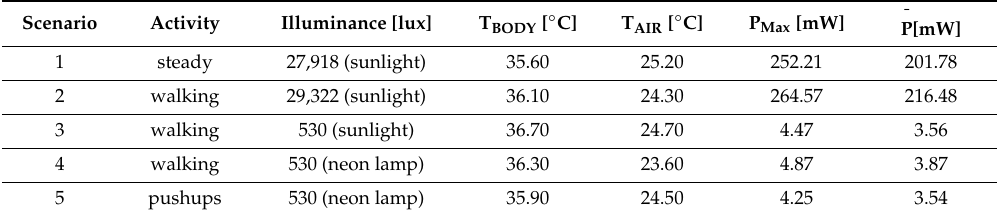
Table 4. Characterization of the multi-source energy harvesting system integrated into the designed smart garment in the five di ff erent